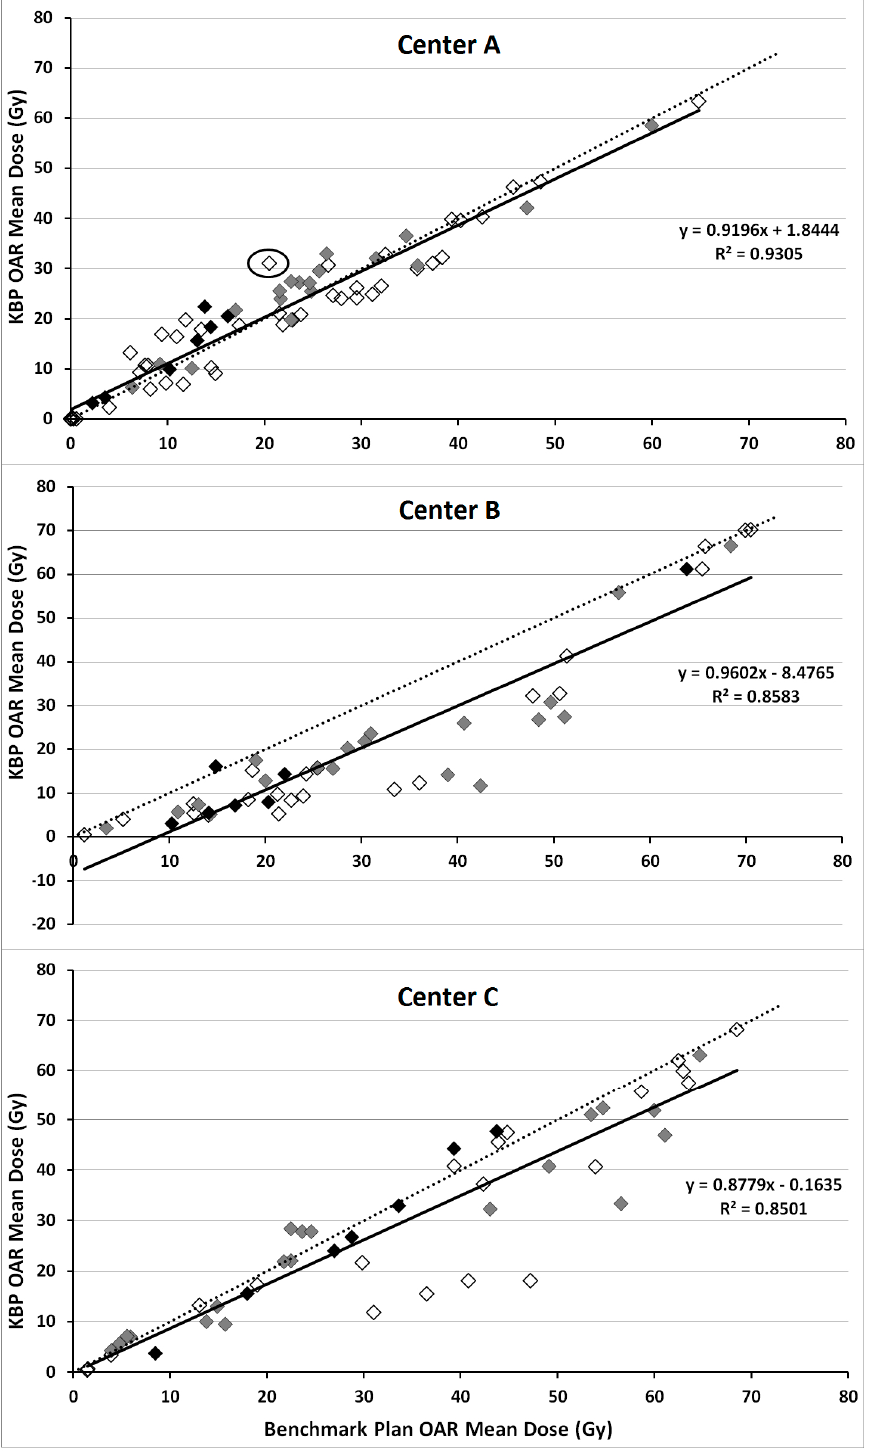
Figure 4. Correlation between mean dose of the salivary glands (grey), oral cavity (black) and all other OARs listed under “mean dose” from Table 2 (white) in knowledge-based plans (KBPs) (vertical-axis) and respective benchmark plans (horizontal-axis). Dotted line indicates line through the origin with slope of 1 while solid line represents linear fit through data points.